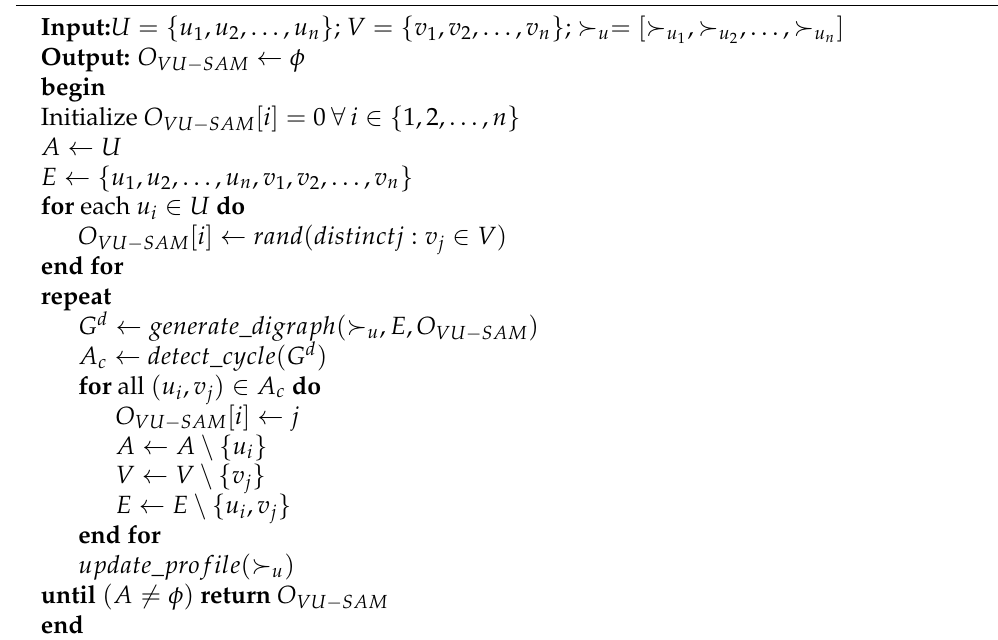
Algorithm 2 VSP-User Single-Allocation Mechanism